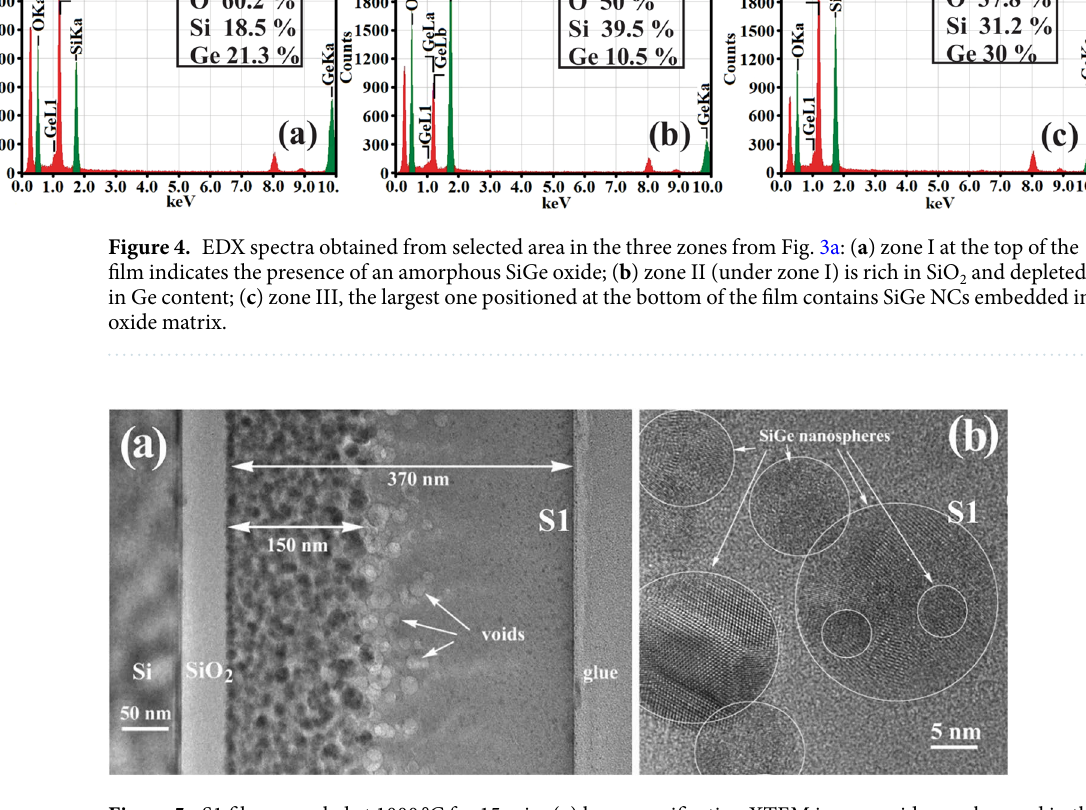
Figure 5. S1 film annealed at 1000 °C for 15 min: ( a ) low magnification XTEM image; voids are observed in the middle part of film; ( b ) high resolution detail of SiGe crystalline